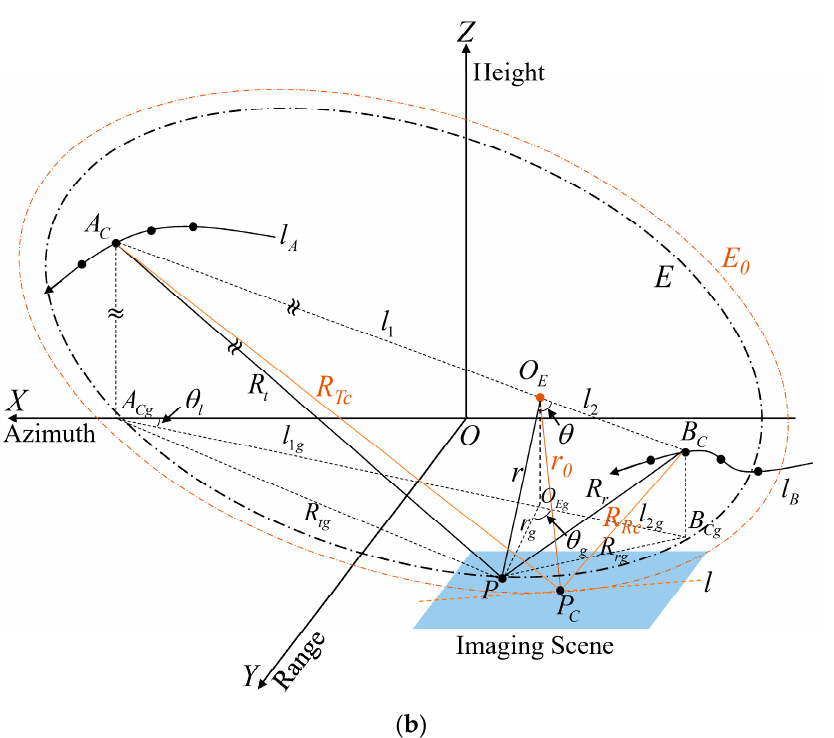
Figure 2. Subaperture imaging geometry of the GEO-UAV BiSAR in the orthogonal elliptical coordinate system. ( a ) The k th subaperture and subimage grid; ( b ) The k th OEP coordinate system. In Figure 2, l A and l B are also the flight trajectories of the GEO satellite and UAV, respectively. The center synthetic time of the k th subaperture is denoted by η c , and the centers of the subapertures for the satellite and aircraft are, respectively, A C ( x T , y T , z T ) and B C ( x R , y R , z R ) . The imaging area is located in the Z -plane in the Cartesian coordinate system, and the center of the imaging scene is P C ( x c , y c , 0 ) . The distances from A C and B C to P C are denoted by R Tc and R Rc , respectively. An OEP coordinate system is established based on A C , B C and P C . E 0 is the ellipse (the orange dashed line) with A C and B C as the focal points and passing through P C . The tangent line l to E 0 at P C , with the normal to this tangent line, intersects A C B C at the point O E . We choose O E as the origin of the OEP coordinate system. The distance from O E to A C , B C and P C are l 1 , l 2 and r 0 , respectively. In the ellipse E 0 (the black dash–dot line), and let 2 c be the distance between A C and B C ; then, the eccentricity e is equal to 2 c / ( r Tc + r Rc ) . According to the properties of an ellipse, we have ∠ A C P C O E = ∠ B C P C O E , so we can obtain the following relationship, i.e.,